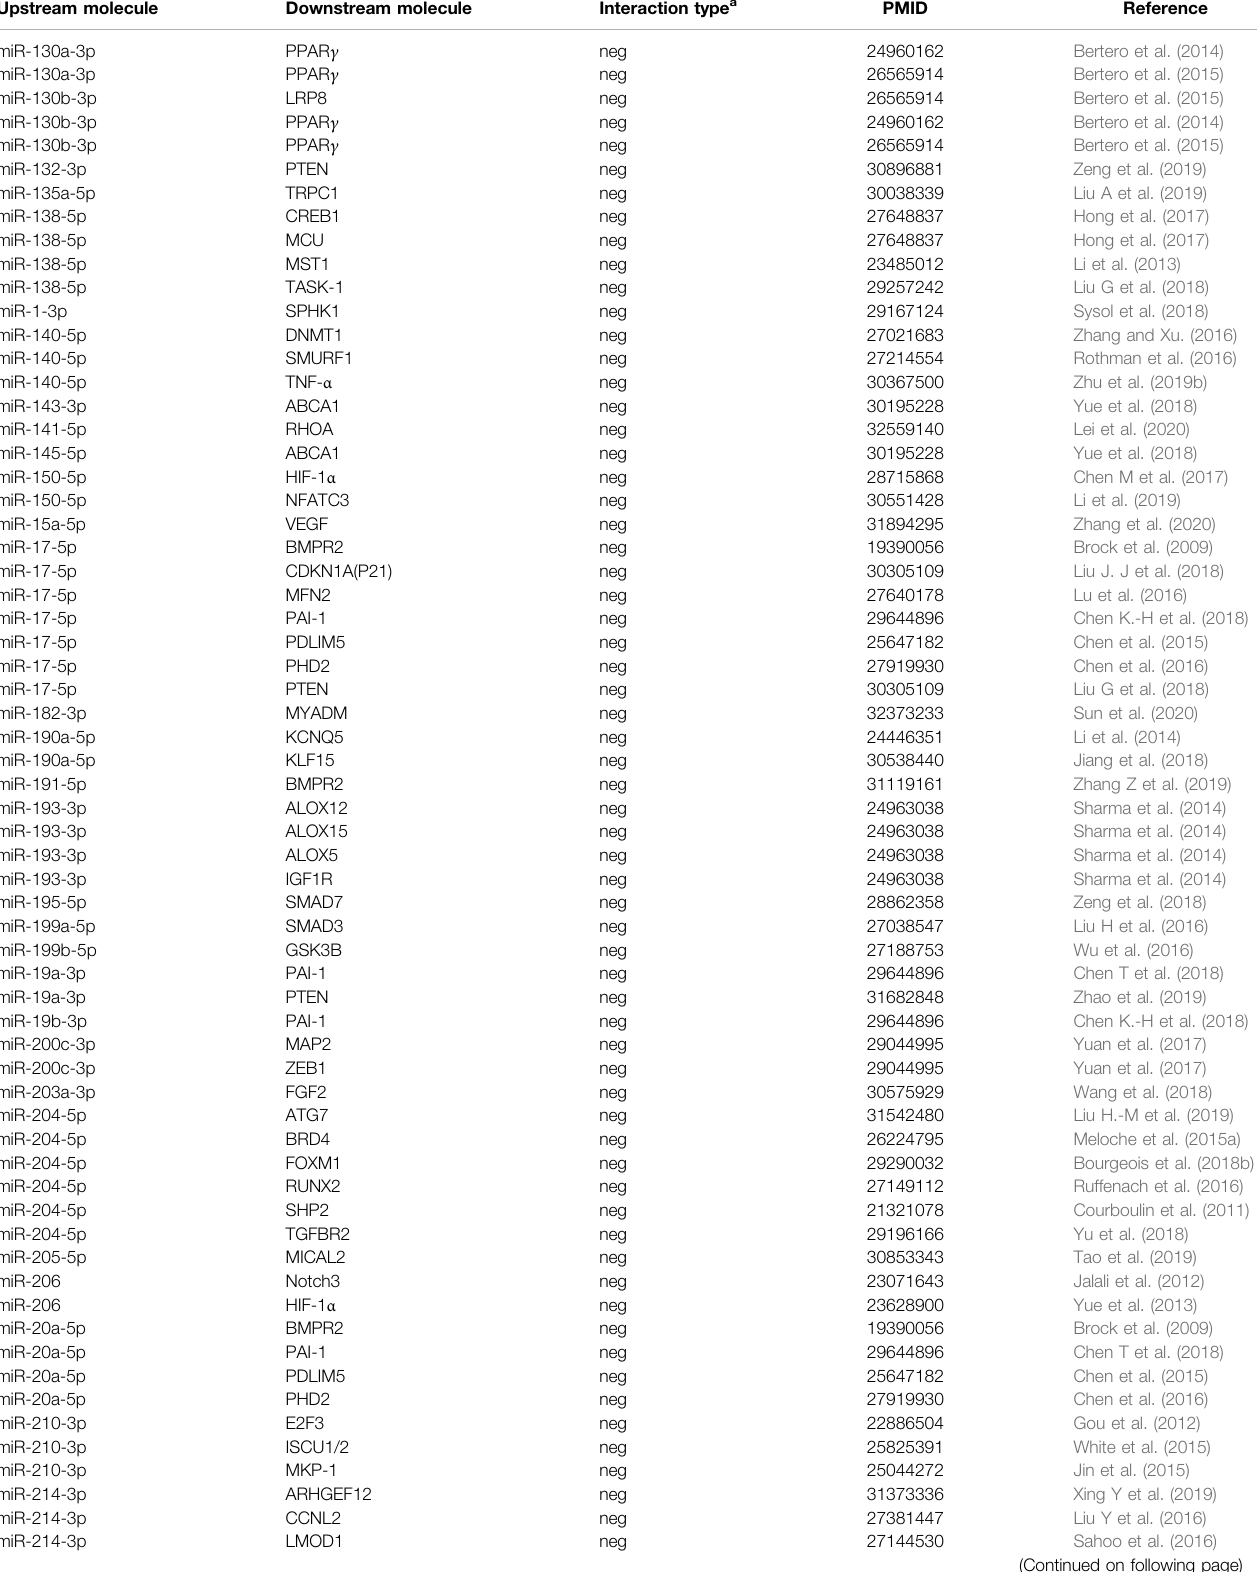
TABLE 2 | ( Continued ) List of network